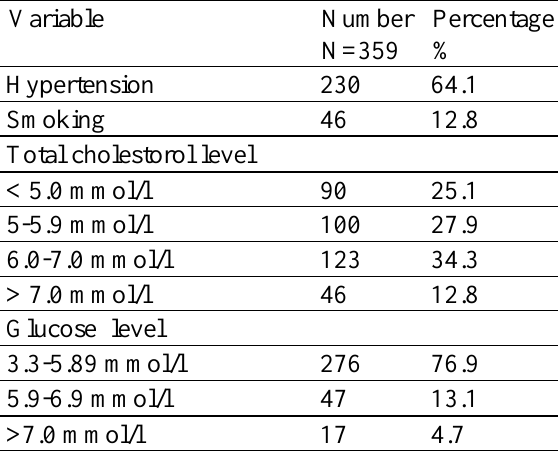
Table 4. Cardiovascular disease risk